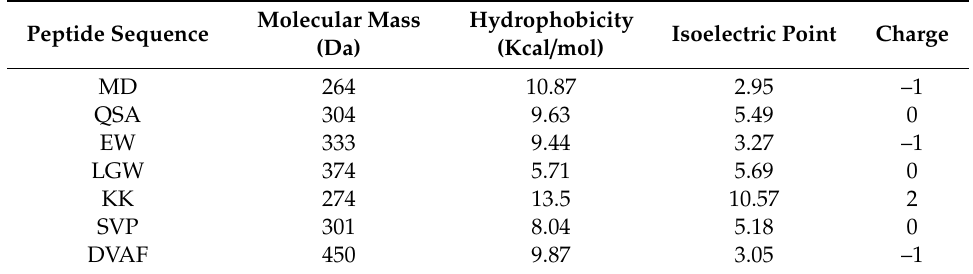
Table 4. Sequences and Functional Properties of Mung Bean Albumin Peptides Derived from Simulated Gastrointestinal Digestion. Peptide Sequence